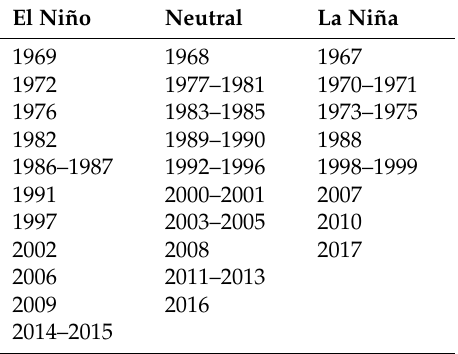
Table 1. List of ENSO years used here. The years below are taken from [30]. El Niño Neutral La Niña 1969 1968